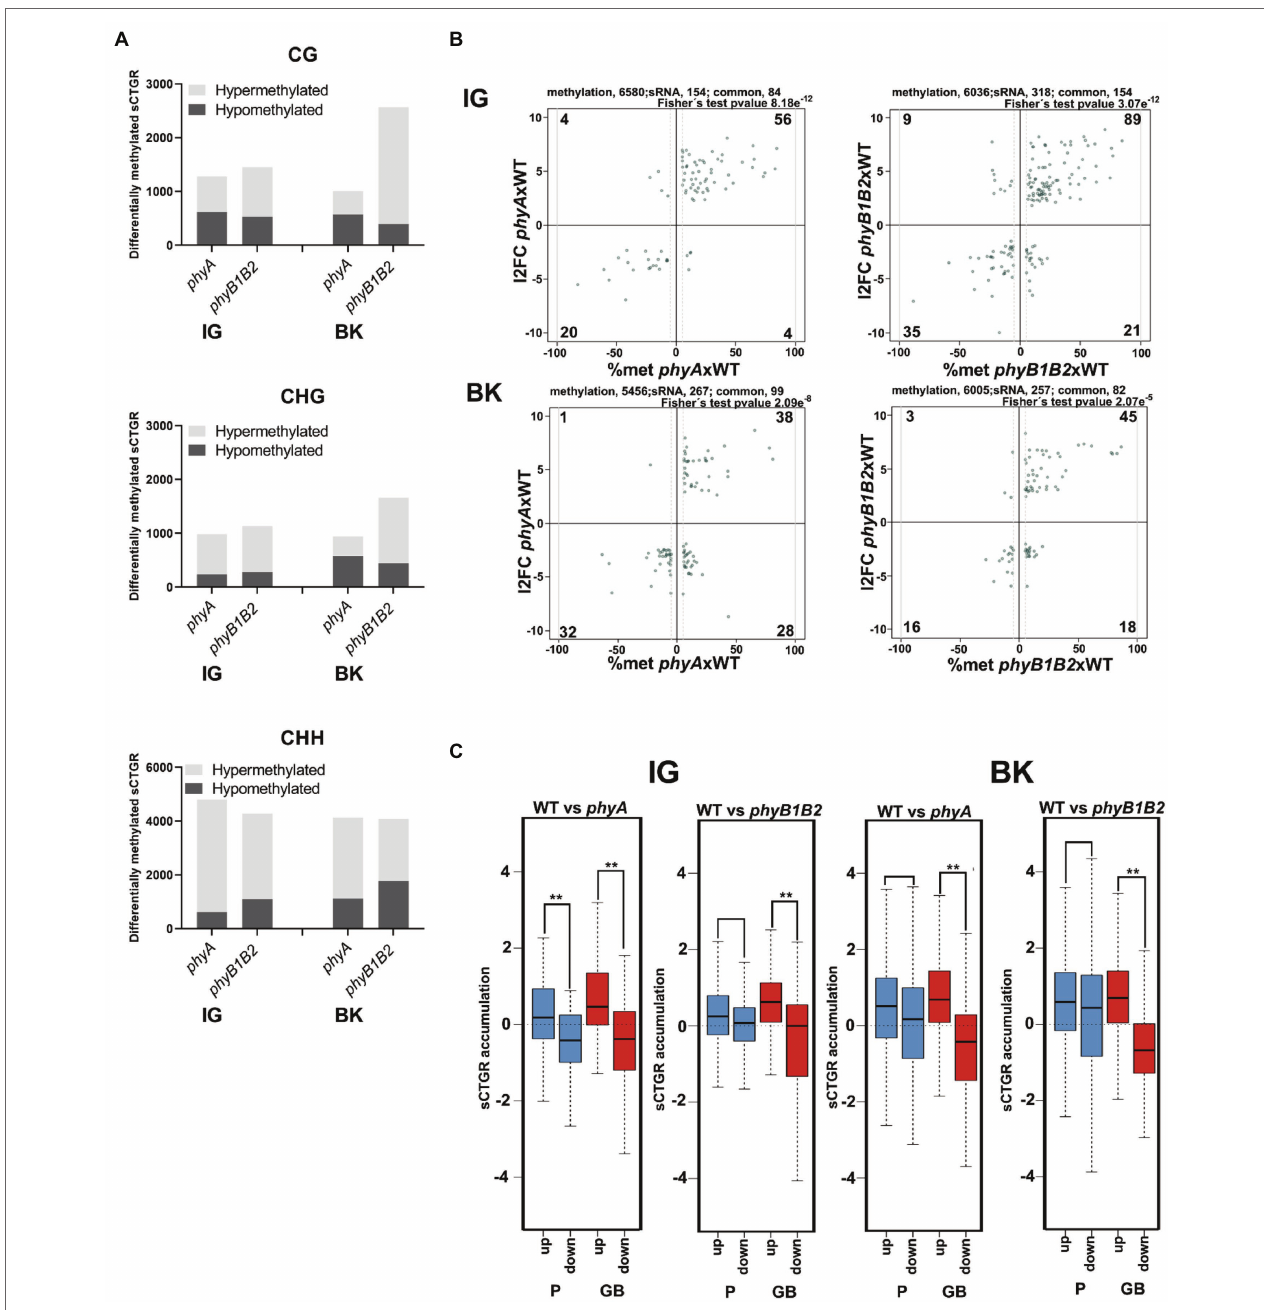
FIGURE 3 | Phytochrome deficiency impacts the sRNAome profile. (A) Total number of differentially methylated sRNA cluster-targeted genome regions (sCTGRs). (B) Scatter plots show the relationship between the differential accumulation of cluster sRNAs and a minimum of 5% differential methylation of their sCTGRs. The result of Fischer’s test for the association of the two datasets is shown ( p ≤ 2.07e − 5 ). (C) Boxplots show changes in the accumulation of cluster sRNAs in promoter (P, 2 Kb upstream of the 5 ′ UTR end) and gene body (GB) regions for up- and downregulated DEGs. Asterisks indicate statistically significant differences by the Wilcoxon–Mann–Whitney test (** p < 0.0001). All results represent the comparison of phyA and phyB1B2 to the wild type in immature green (IG) and breaker (BK) fruit